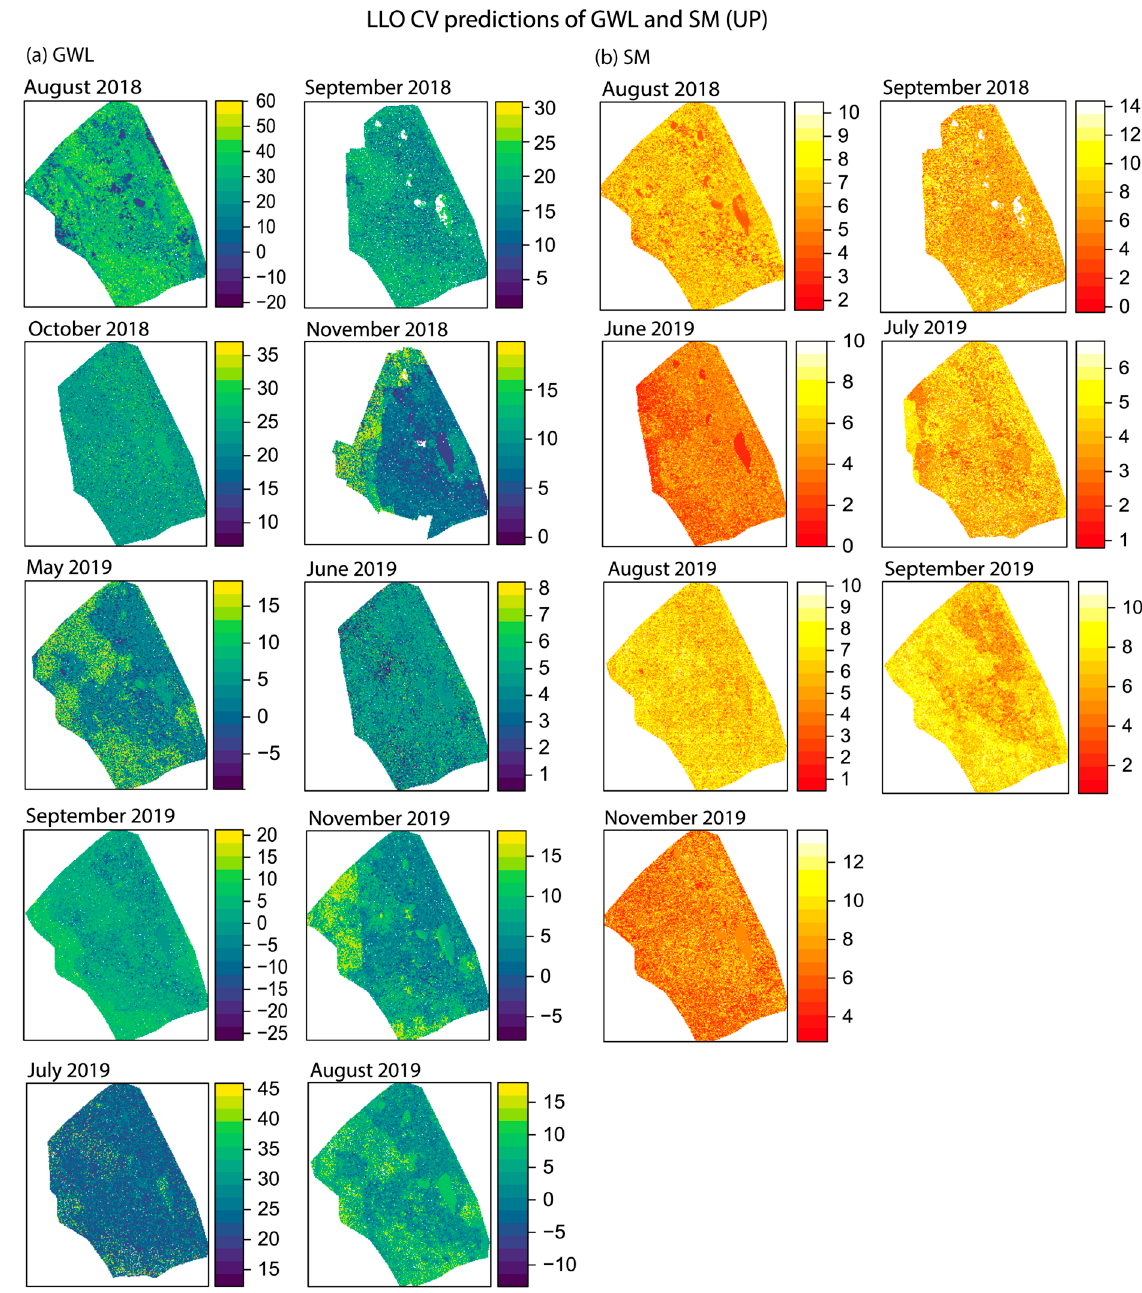
Figure 6. ( a ) Relative GWL (August 2018-November 2019; blue-green) and ( b ) SM (August 2018-November 2019; orange- yellow) spatial temporal prediction maps of the UP showing the prediction error assessed by the RMSE.